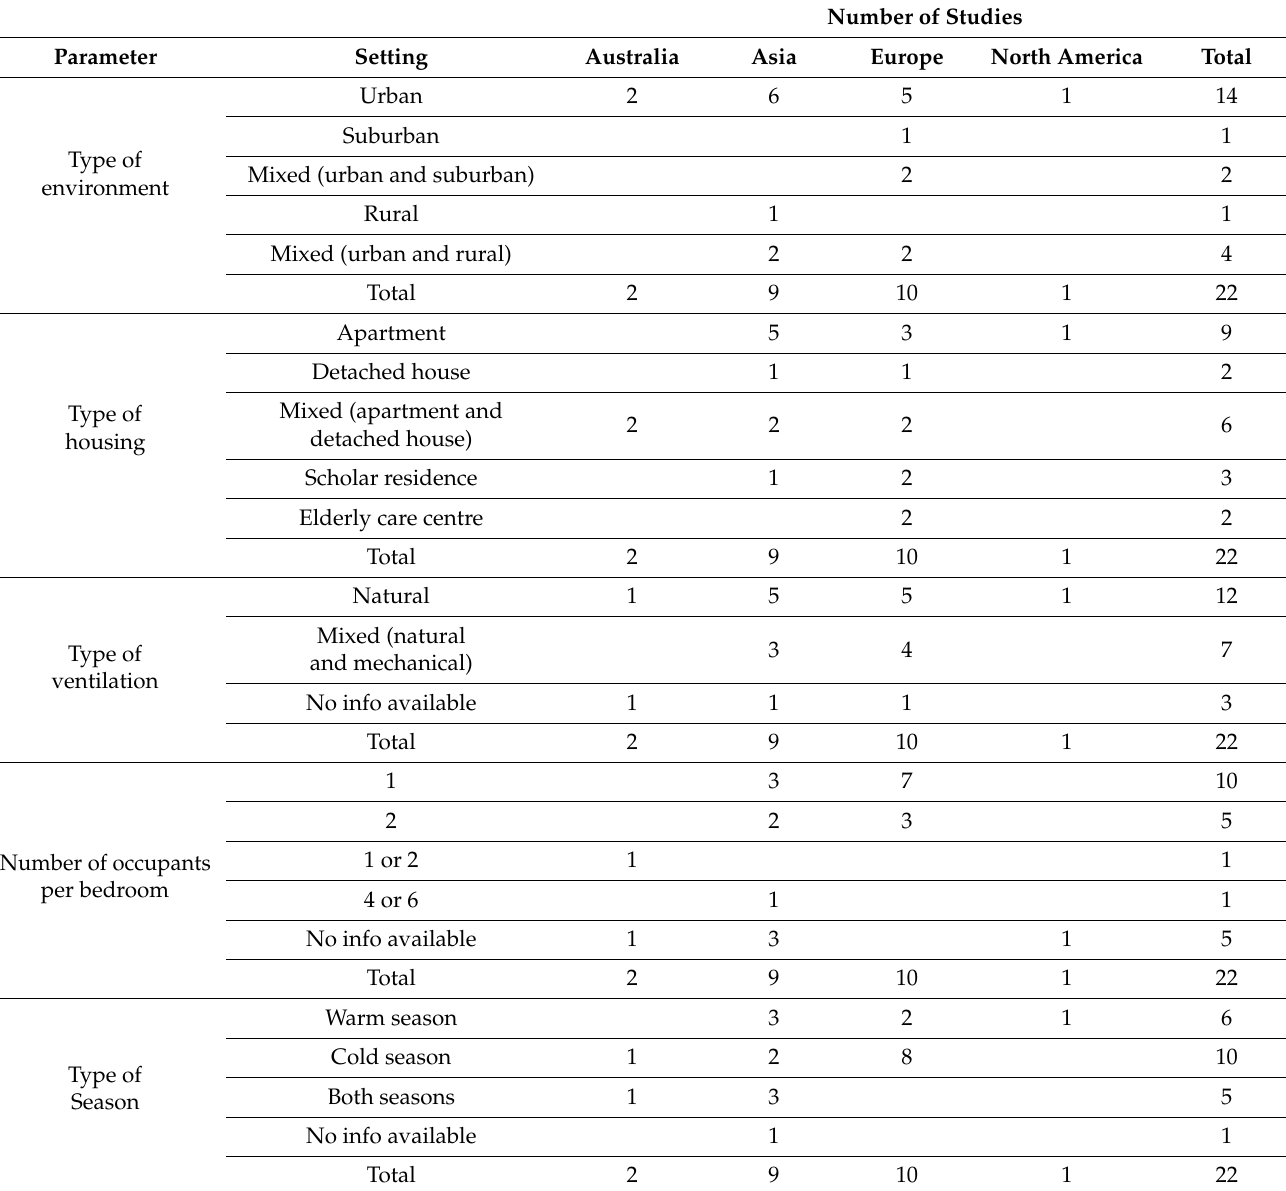
Table 1. Characteristics of selected studies regarding type of environment, housing, ventilation, number of occupants per bedroom and